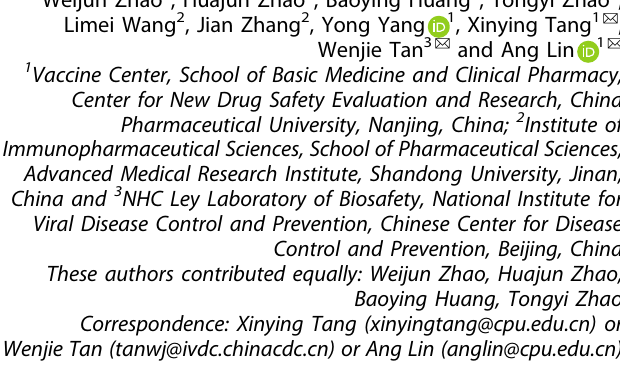
Fig. 1 In-depth pro fi ling of vaccine responses in mice receiving two-dose inactivated vaccines followed by homologous booster or heterologous booster with Ad5-nCoV. a Overview of study design. b Endpoint titers of Spike- and RBD-speci fi c IgG are shown. Spike-speci fi c IgA titer is depicted as OD450 value ( n = 6). c Neutralizing Abs against SARS-CoV-2 wide-type strain, Delta and Omicron variants were measured using pseudotyped virus neutralizing test ( n = 6). d PCA analysis of proteome in plasma collected 12 h following booster. e Quanti fi cation of indicated proteins in each group. Data is shown as fold change normalized to the PBS group ( n = 3). Asterisks indicate the statistical difference compared to PBS group. f Splenocytes were stimulated with Spike protein (5 μ g/ml) for 8 hours in the presence of Brefeldin A ( n = 6). Frequencies of IFN- γ , TNF, IL-2, IL-4 or IL-21-secreting T cells were evaluated by fl ow cytometry. Representative data is shown. g Quanti fi cation of cytokine-producing memory CD4 + T cells in vaccinated mice ( n = 6). Negative control (PBS) values were subtracted. The ability of T cells to produce single (1 + ), double (2 + ) or triple (3 + ) types of Th1-cytokines (IFN- γ , TNF, IL-2) was analyzed using SPICE software. h Representative gating strategy of Spike + class-switched MBC and PC in spleen. i Frequencies of Spike + class-switched MBCs and PCs in the indicated lymphoid organs were assessed ( n = 6). j Shannon ’ s entropy index and D50 value indicating BCR clone diversity are shown. Somatic hypermutation (SHM) rate in the IGHV and IGHJ genes is shown. k Percentage of IGHV or IGHJ gene segments with mutated or unmutated CDR3 out of total reads. l Percentage and distribution of CDR3 with different length. m Frequency of usage of IGHV-J gene pair is shown. n Pie charts show the distribution of top 100 dominant BCR clones. The number inside the circle indicates the number of total sequences analyzed. * p ≤ 0.05, ** p ≤ 0.01, *** p ≤